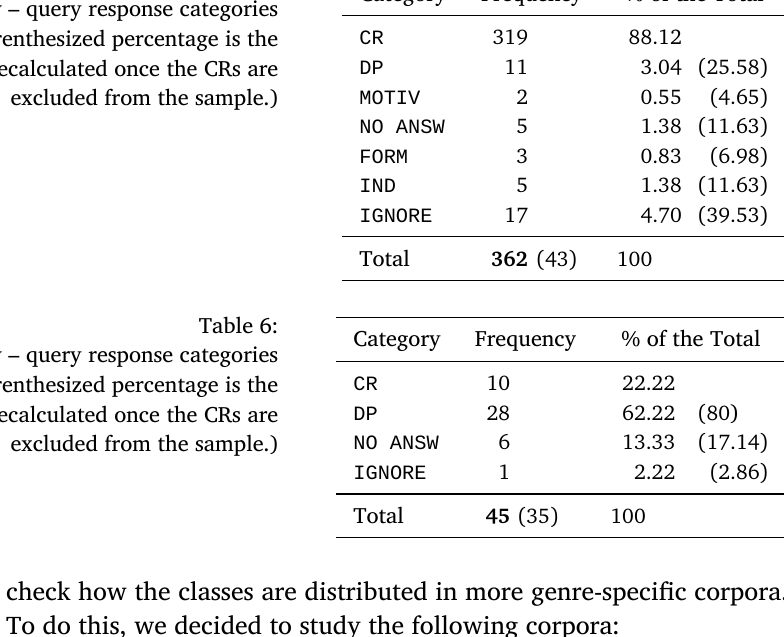
Frequency of query – query response categories (CHILDES) (The parenthesized percentage is the percentage recalculated once the CRs are excluded from the sample.)